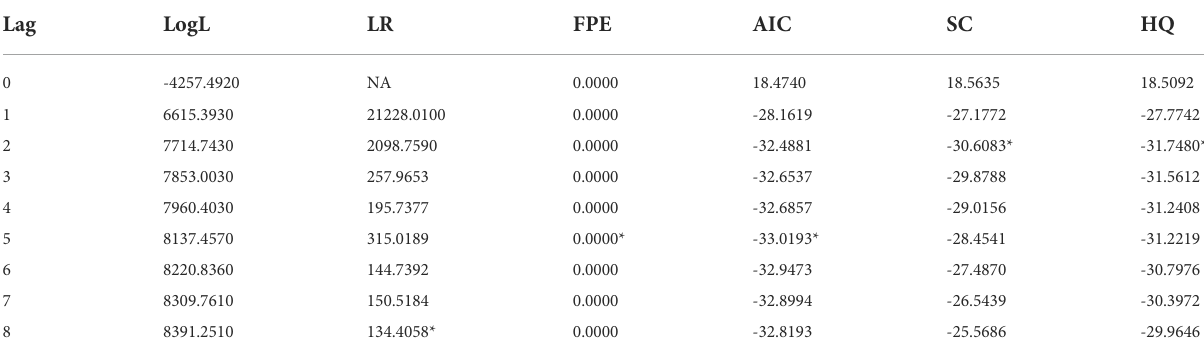
TABLE 6 Results of lag length selection criteria.